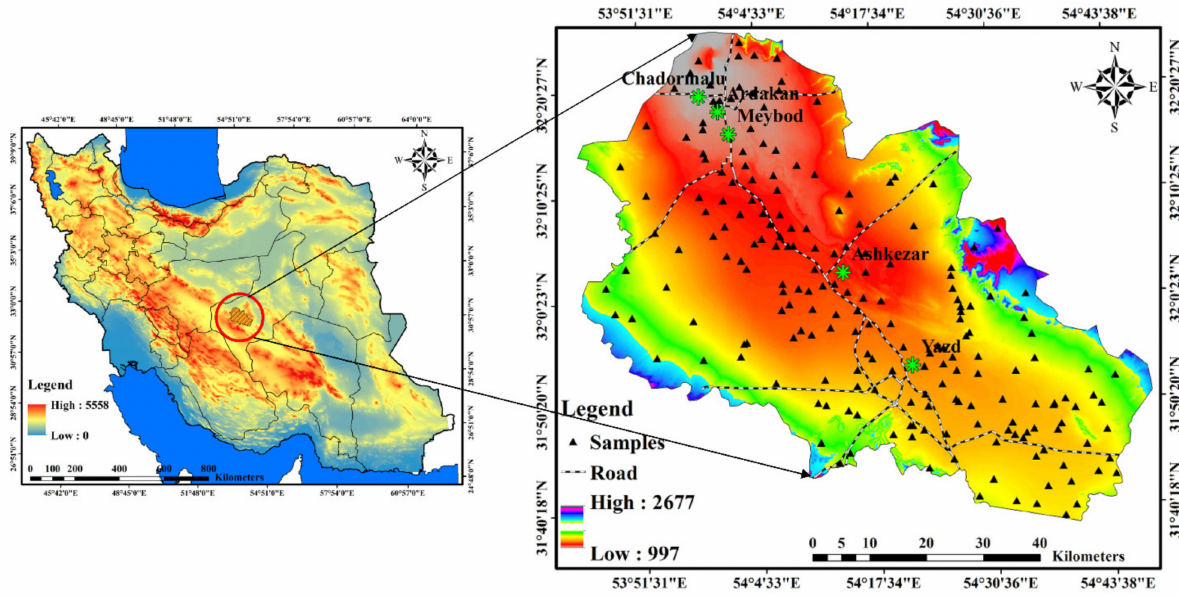
Figure 2. Location of the study area and the distribution of sampling points with respect to elevation